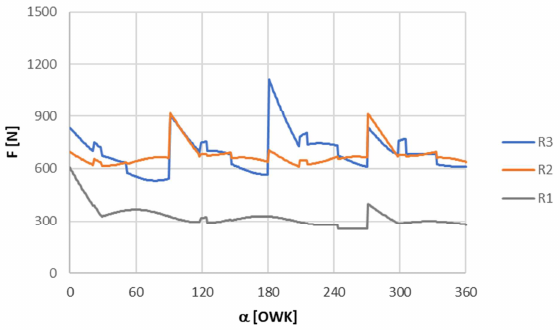
Fig. 14. The reaction values in camshaft bearings as a function of the rotational angle for its average rotational speed of 750 rpm and belt tension of 50 N